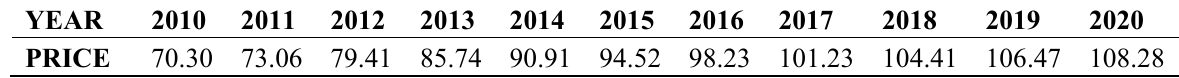
Table 1. Oil prices forecasted [26].